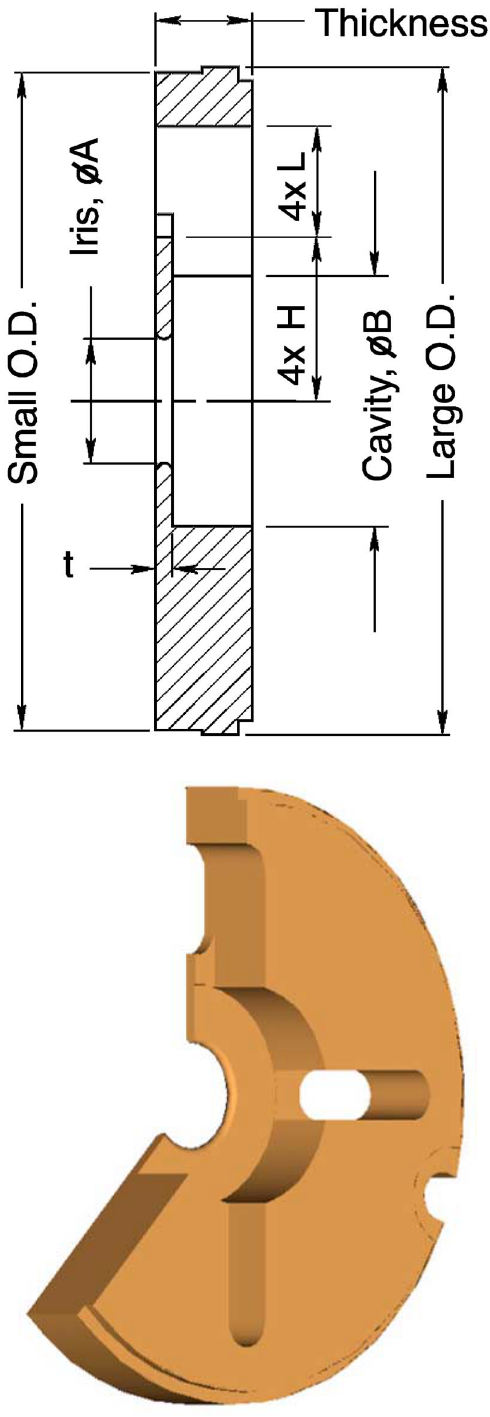
FIG. 2. (Color) Cross section and rendering of the DDS-3